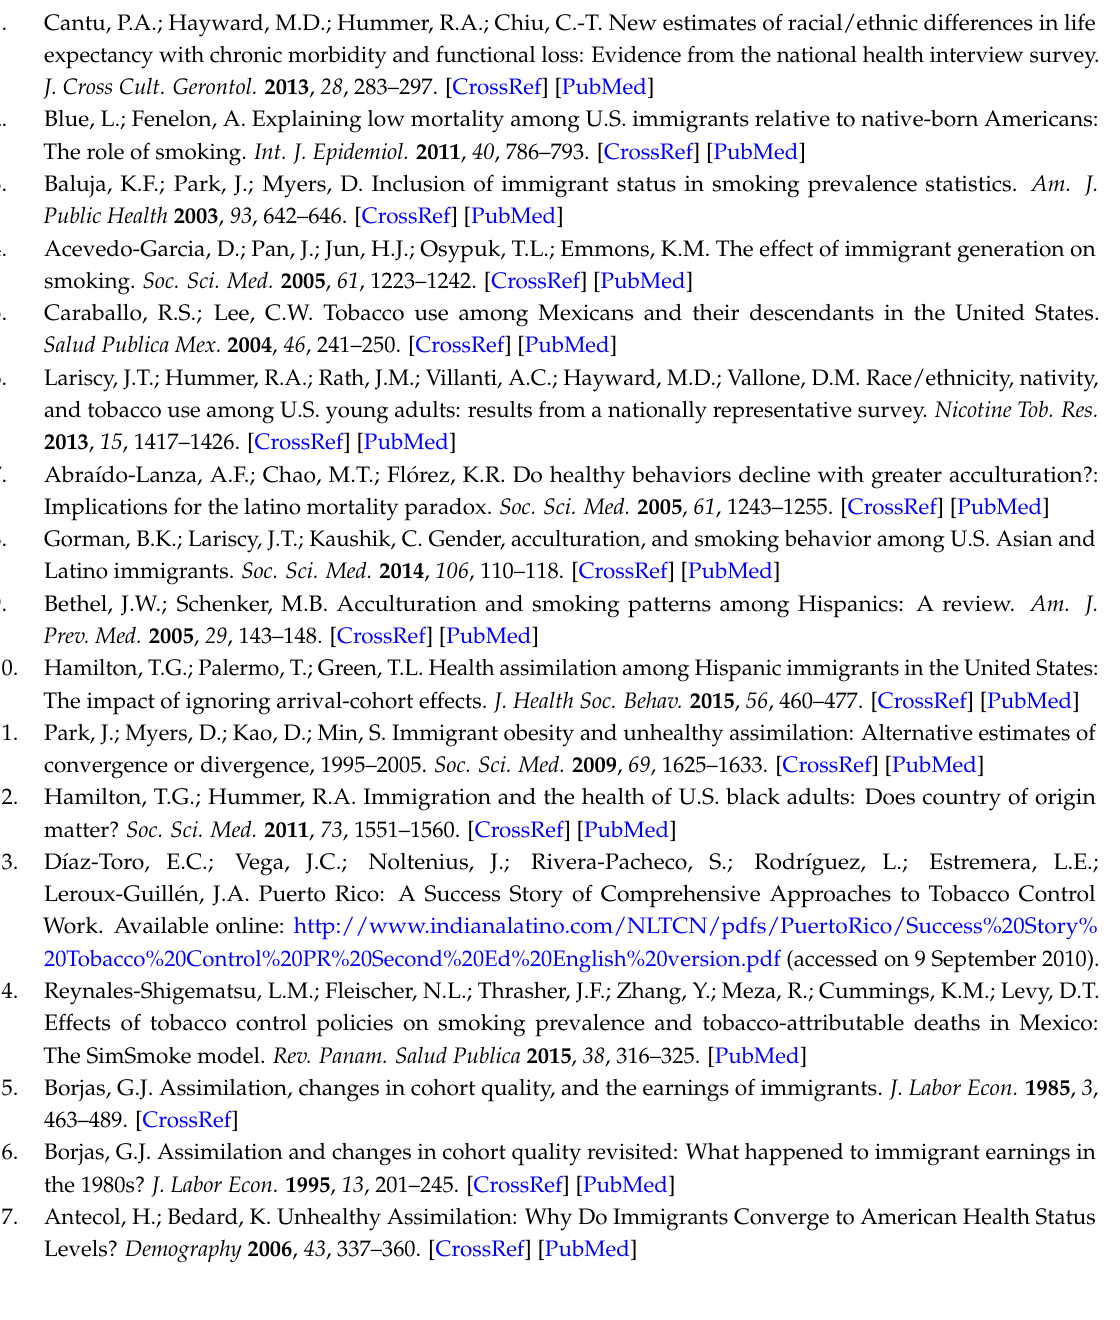
Table S1: Logistic regressions predicting current smoking among Hispanic men (period and duration